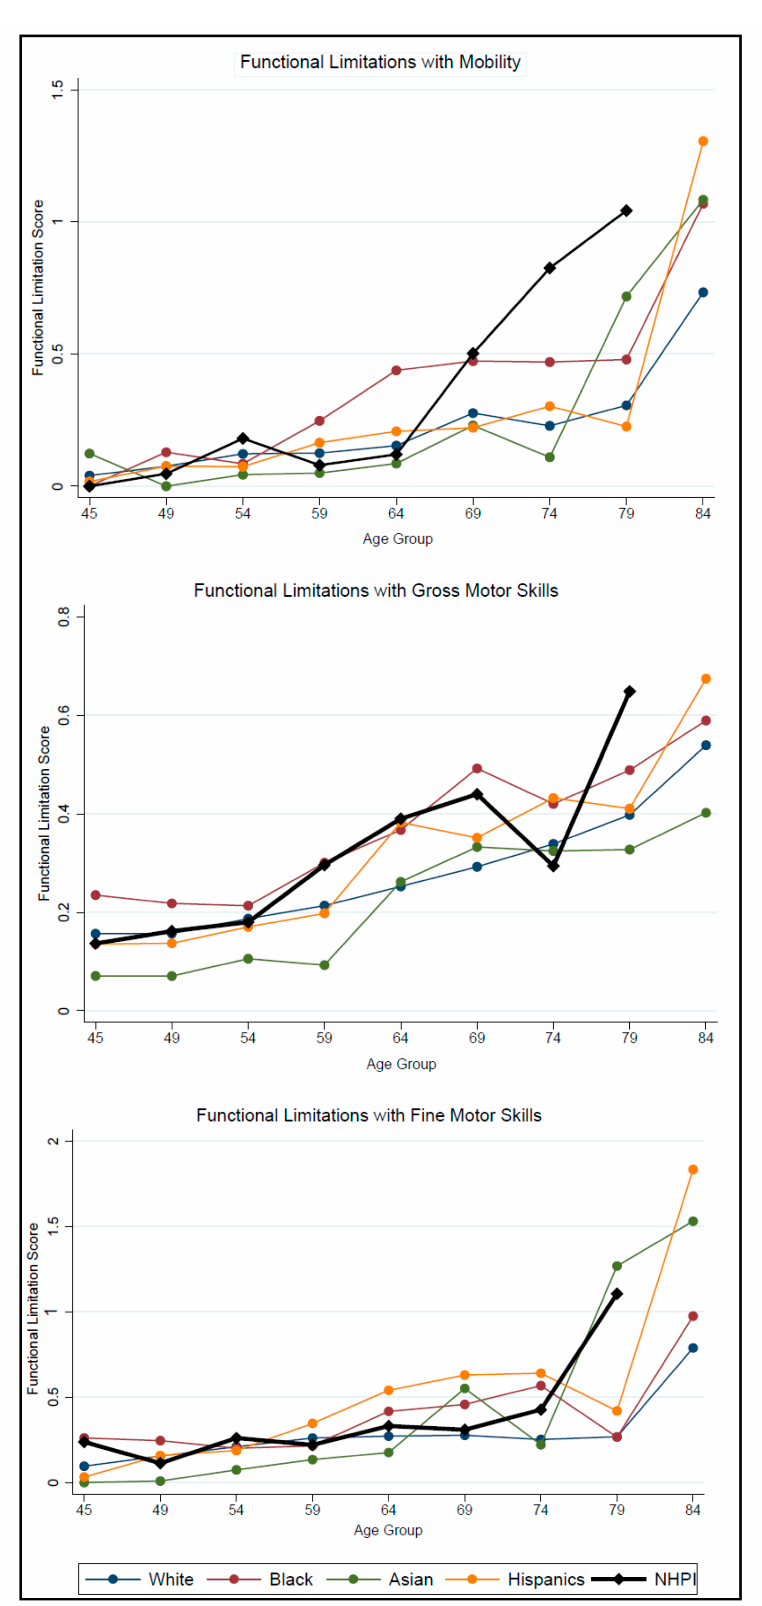
Figure 1. Showing the functional limitations by race/ethnicity and age group for Mobility, Gross Motor Skills (GMS), and Fine Motor Skills (FMS), respectively. Higher scores indicate more difficulties for all three functional limitation domains. Note: NHPI = Native Hawaiian and Pacific